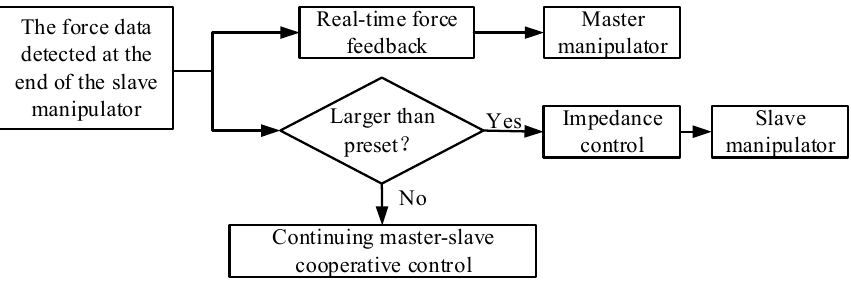
Figure 11. Flowchart of force control procedure.